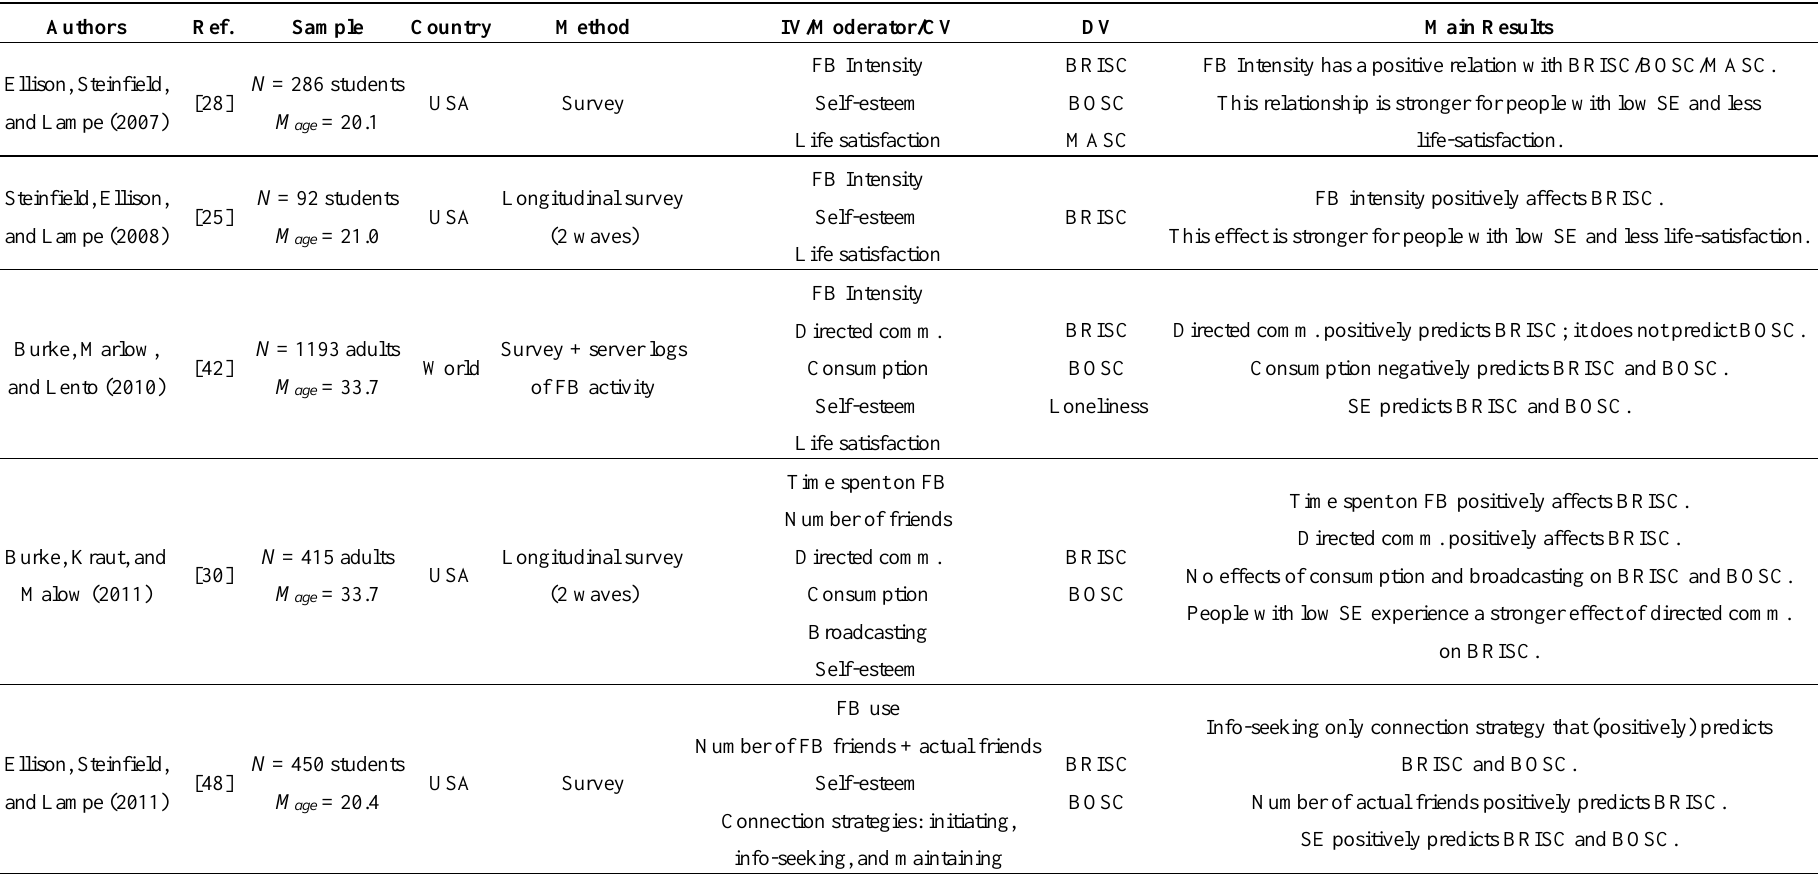
Table 1. Studies on Facebook and micro-level social